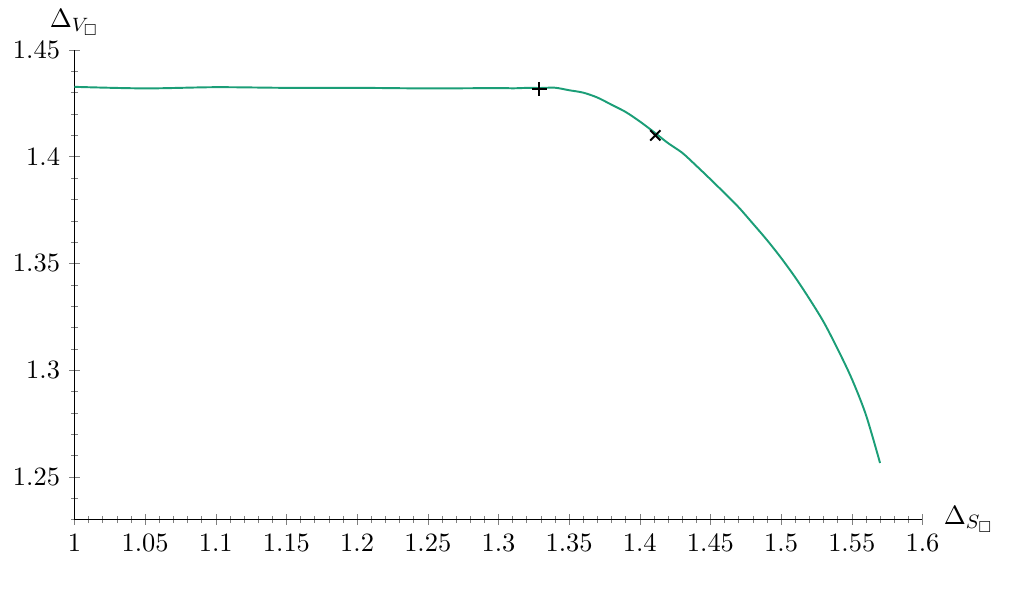
Figure 6 . Upper bound on (cid:1) V The x- and +-markers indicate the position of the decoupled Ising and the C b